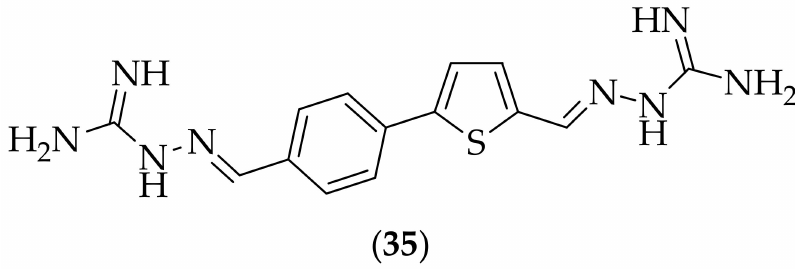
Figure 21. Lead thiophene-based bis-guanylhydrazone antifungal compound ( 35 ). In 2018 the same group published on additional bis-guanylhydrazones as effective agents for the treatment of candida infections, [50]. The group synthesized three new bis-guanylhydrazones, as close analogs of their previous lead molecule ( 35 ), and tested them against four Candida strains. The results showed that compound ( 36 ), Figure 22, was the most active analog, with MIC values comparable to the two positive controls, nystatin and amphotericin B, and that ( 36 ) showed the lowest cytotoxicity against healthy human fibroblasts (MRC5) of the three analogs (40 µ g/mL). The potential of compound ( 36 ) to interact with chromosomal DNA from Candida albicans was investigated, with the result showing that the compound did appear to interact with DNA, for which additional evidence was presented though the use of circular dichroism spectral analysis, which showed that the compound significantly perturbs the conformation of double stranded template DNA (dsDNA). The DNA-specific probe DAPI was utilized to investigate the pro-apoptotic effect of ( 36 ). The result of this work showed that there was a significant decrease in the intensity of the blue color associated with the DNA-DAPI complex in the Candida albicans cells treated with the MIC of compound ( 36 ), indicating perturbation of the conformation of the dsDNA. The reactive oxygen species (ROS) generation and accumulation caused by ( 36 ) was found to be significantly lower than for amphotericin B. The synergism between ( 36 ) and known antifungal agents was investigated, which showed that ( 36 ) and amphotericin B acted synergistically against Candida albicans and Candida parapsilosis , but that ( 36 ) did not act synergistically with nystatin or itraconazole against these two Candida species. As only three additional derivatives were synthesized this only provides a small sample size to select from. It would be instructive to see more analogs made, preferably of ( 36 ) as it is the superior compound, to incorporate substituents on to the phenyl ring, incorporate substituents on to the furan ring, phenyl replacements such as pyridyl and thiophene, and furan replacements such as oxazole and oxadiazole.